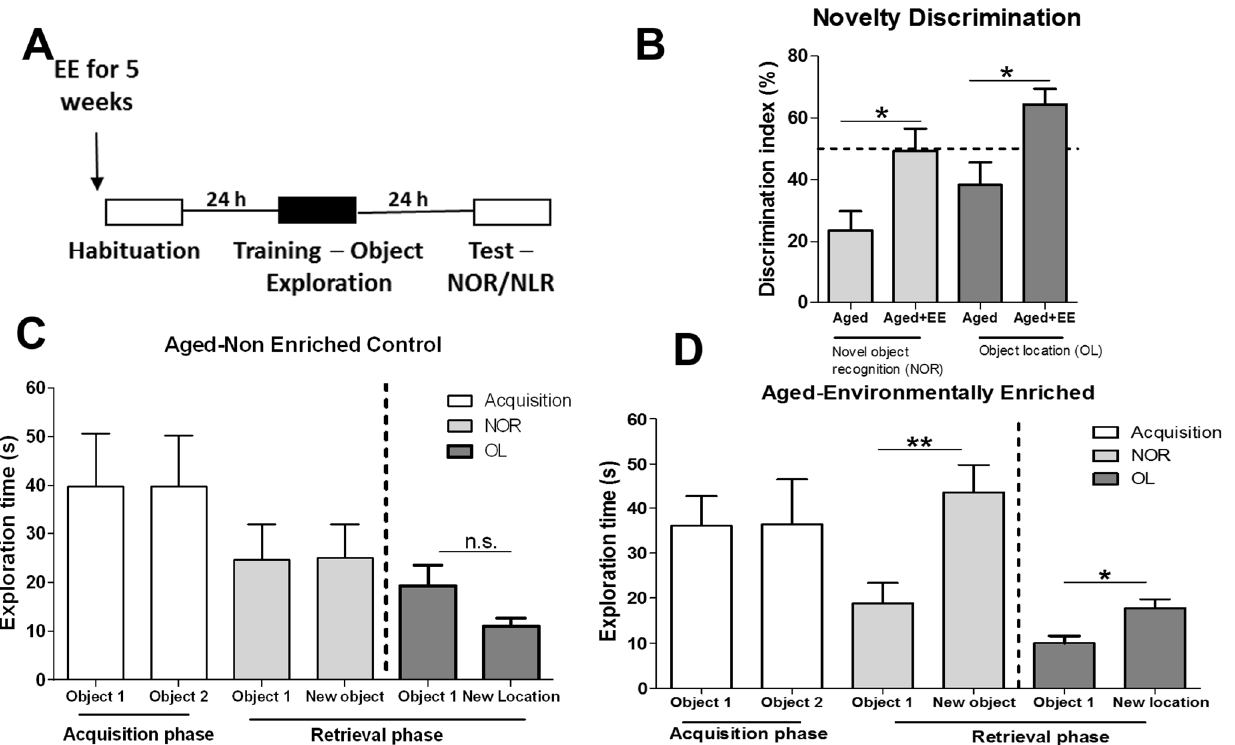
Figure 6. Environmental enrichment restores memory formation in aged adults. ( A ) Aged adults experience a 5-week EE protocol prior to behavioral experiments. Age-matched non-enriched controls received similar handling procedures; ( B ) A Novelty discrimination index indicate that memory impairment in aged adults was rescued with EE. Object exploration during training and testing phases (NOR and OL) for non-enriched aged controls ( C ) and aged-enriched adults ( D ) are presented as the total duration, in seconds, of exploration. Objects 1 and 2 represent the sample objects during acquisition. During the retrieval phase, object 1 represents the familiar object or familiar object location. Group sizes NOR: Aged, n = 5; Aged + EE, n = 6; OL: Aged, n = 4; Aged + EE, n = 5. Student’s t-test ; * p < 0.05 between indicated groups. * p < 0.05, ** p < 0.01 between indicated groups. Error bars represent SEM. Chromatin immunoprecipitation (ChIP) analysis revealed that H3K4me3 levels significantly increased